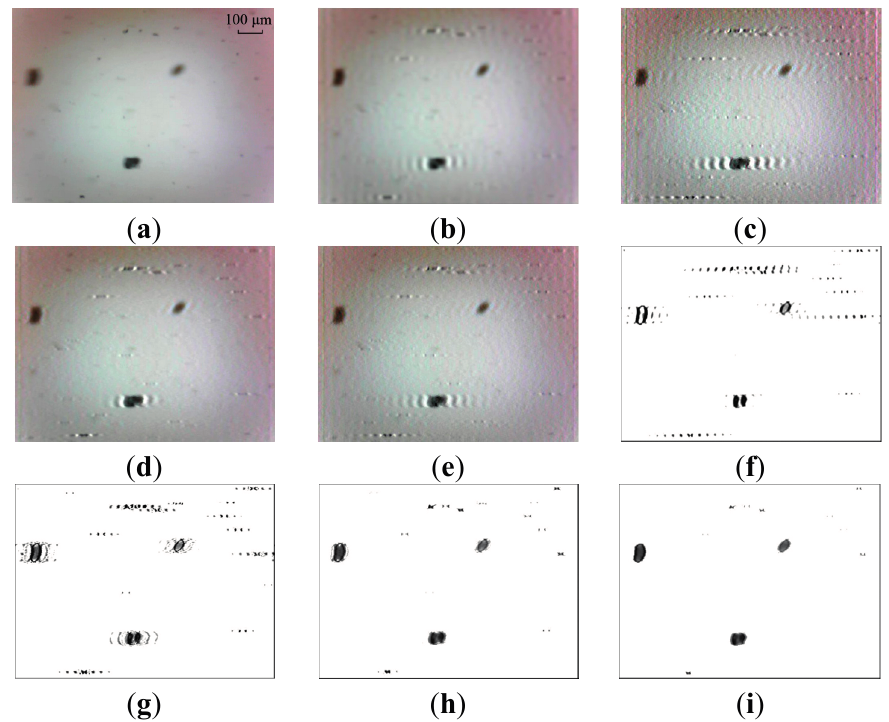
Figure 16. Test results—image 2: ( a ) input image; ( b – e ) restored images by LS, BD, LR and WF based on the whole image, respectively; and ( f – i ) output images by LS, BD, LR and WF based on local blurred regions,